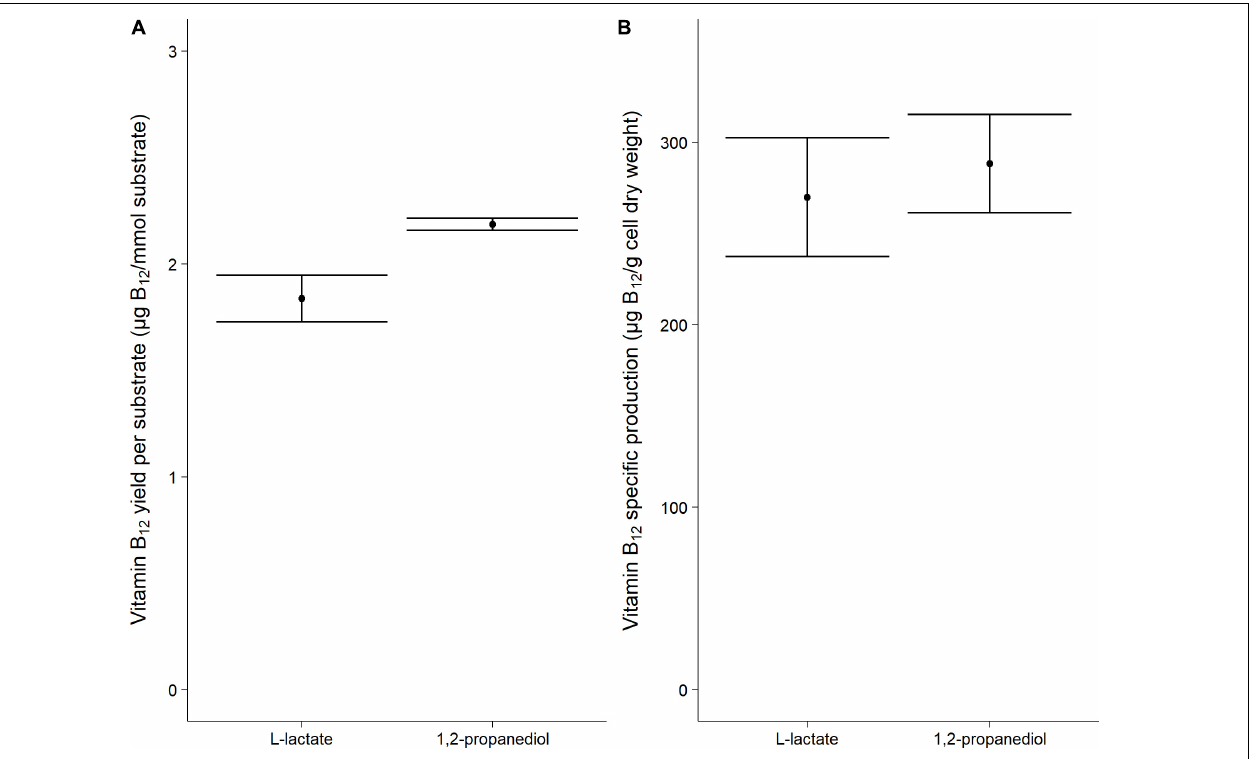
FIGURE 2 | Vitamin B 12 formation in cells grown on L -lactate or 1,2-propanediol. (A) vitamin B 12 yield in µ g/mmol substrate (B) Biomass specific vitamin B 12 production in µ g/g cell dry weight. Error bars = standard error ( n = 3 biological replicates).